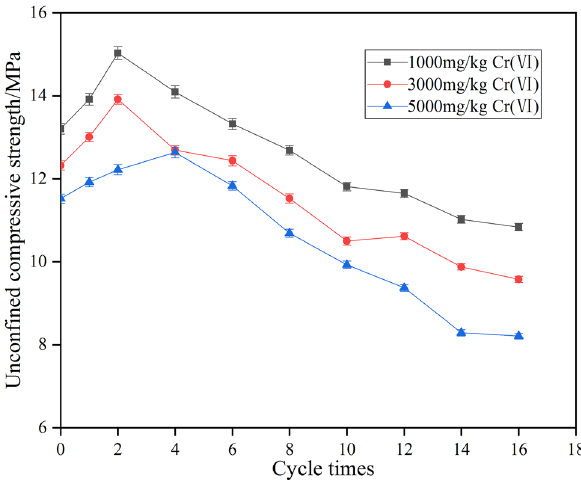
Figure 1. The relationship between unconfined compressive strength and the number of dry wet